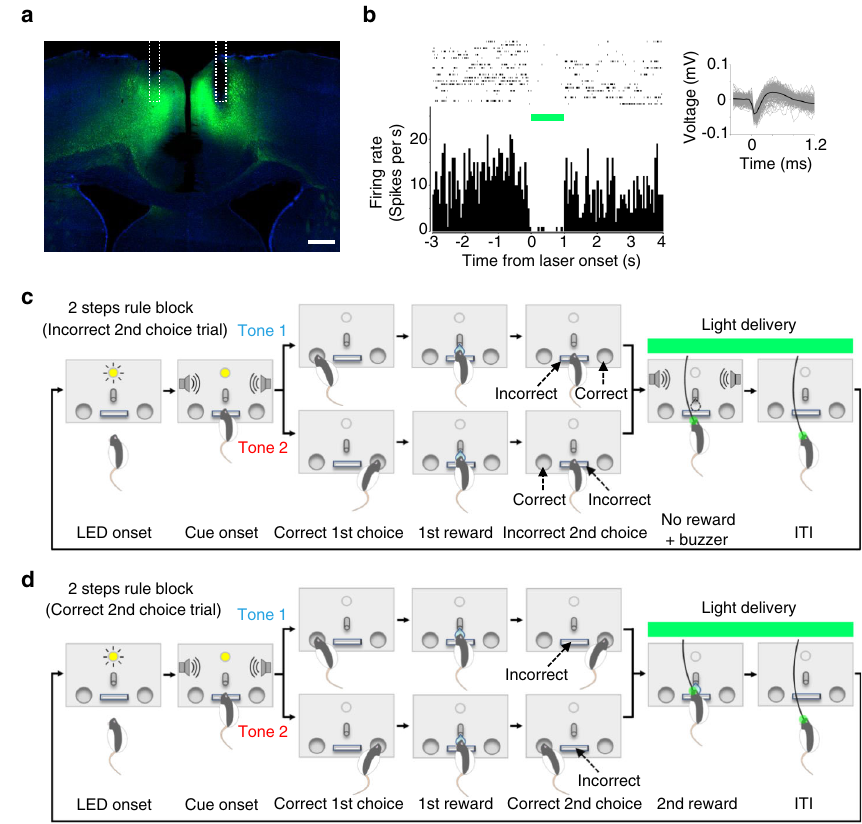
Fig.8|OptogeneticsilencingofACCneuronsduringoutcomefeedbackperiod following animals ’ 2nd choices. a Histological section for halorhodopsin (eNpHR3.0) expression in ACC. Green, eNpHR3.0-eYFP expression. Blue, DAPI. White dotted line shows reconstructed positions of fi beroptic implants. Scale bar, 500 μ m. b Suppression of spiking activity by 561nm light delivery. Top left, raster plot of a representative single-unit measured in ACC showing spiking activities before, during, and after laser light delivery. Top right, example waveforms of the representative single-unit. Bottom left, peri-event